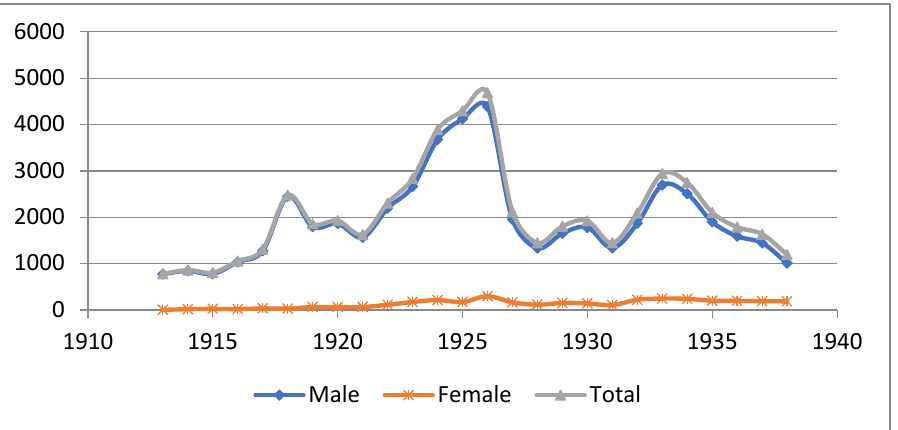
Figure 1. Number of students at the University of Athens per gender, National and Kapodistrian University of Athens, 1913—1938. Source: Statistics Annual 1939.